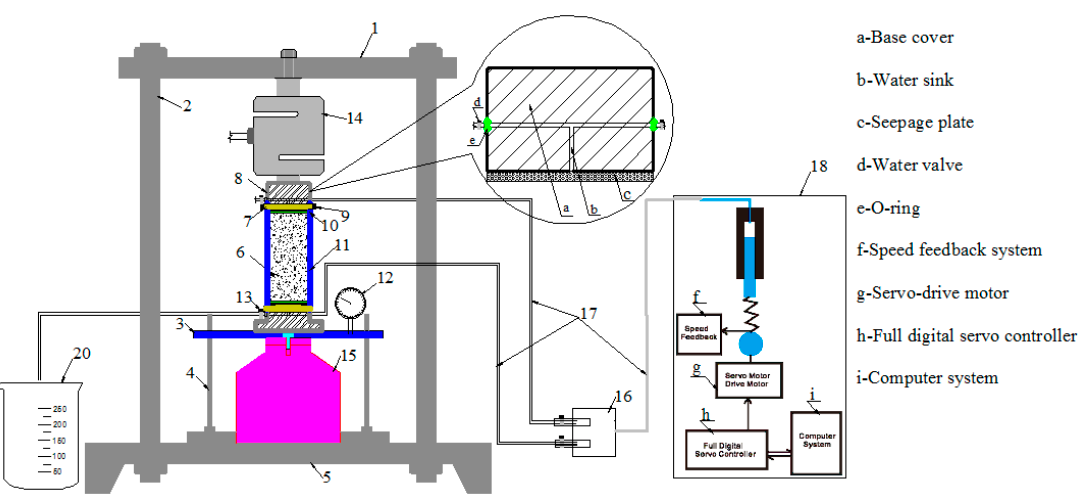
Figure 1. Schematic diagram of the flow testing system [5], which is composed of the rigid sample holder, the servo pressurized water-supply system, and the sample chamber system.